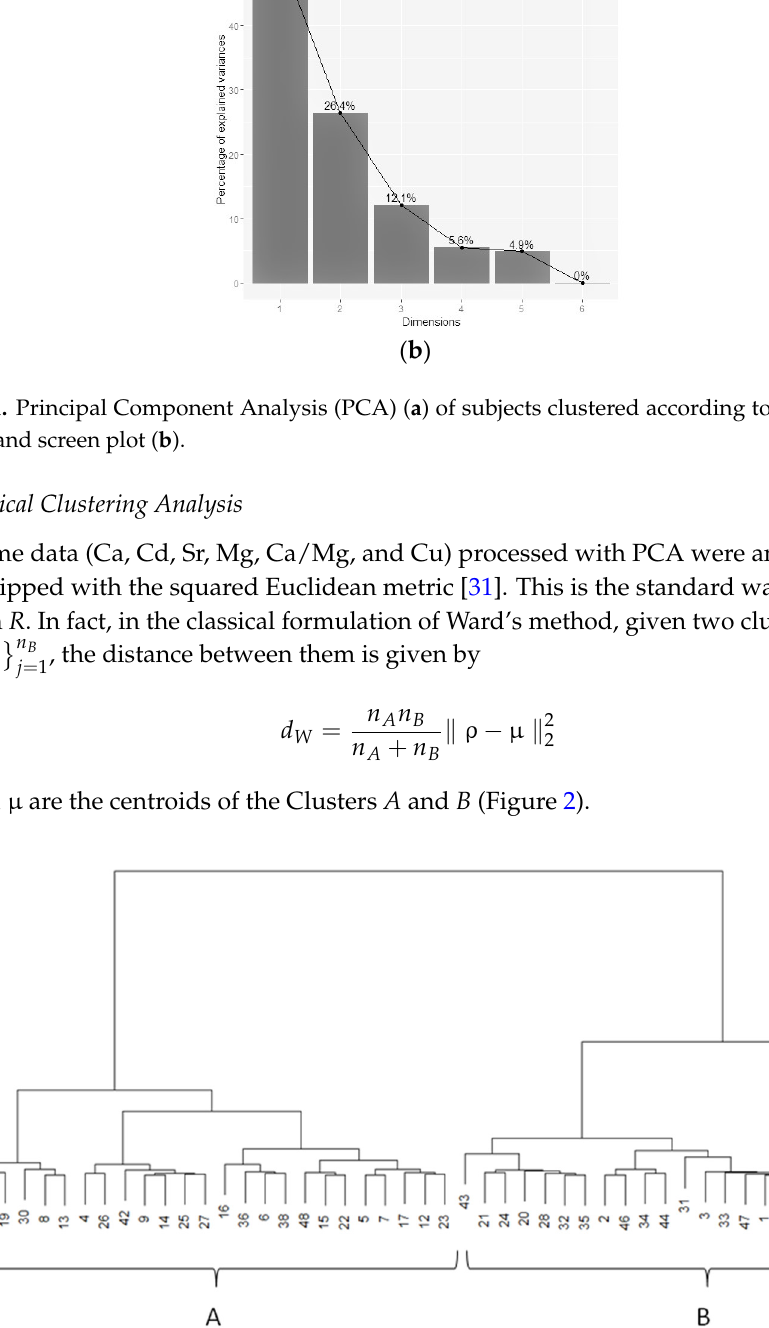
Figure 1. Principal Component Analysis (PCA) ( a ) of subjects clustered according to gender (F =  ; M =  ) and screen plot ( b ).